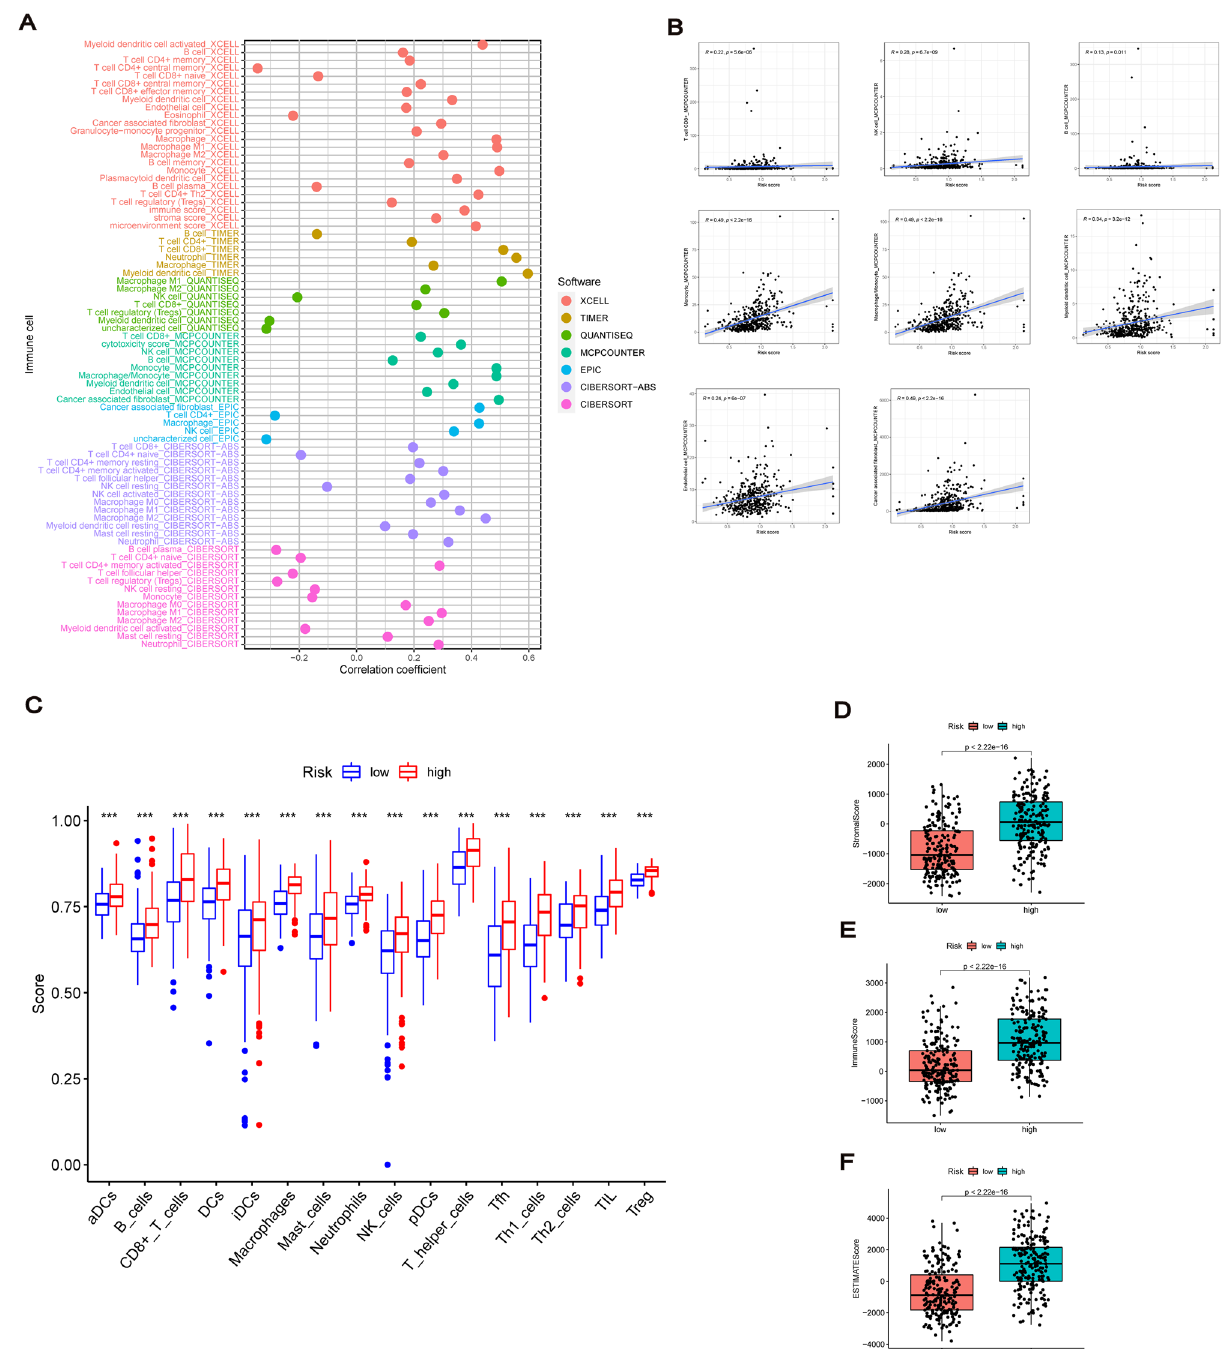
Figure 9. Tumor immune microenvironment for risk signature. ( A ) The immune cell bubble plot showing the abundance of immune cell infiltrates in seven algorithms. ( B ) The correlation results between risk score and immune cell subsets in MCPCOUNTER platform. ( C ) SsGSEA scores in 16 types of immune cells between the two risk subgroups. ( D – F ) The boxplots of StromalScore, ImmuneScore, and ESTIMATEScore in low–risk and high-risk groups. * P < 0.05, ** P < 0.01, *** P <